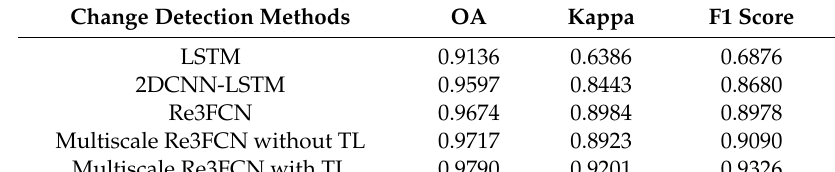
Figure 5. Change detection maps obtained from the proposed and other methods for site 1 including (a) ground truth map (b) LSTM, (c) 2D CNN-LSTM, (d) Re3FCN, (e) the proposed method without transfer learning, and (f) the proposed method with transfer learning. Ω 𝑐 and Ω 𝑢 represent changed and unchanged classes, respectively. Table 3. Comparison of results of assessment parameters for different change detection methods for site 1. “ Kappa ” and “ TL ” represent Kappa coefficient and transfer learning, respectively.